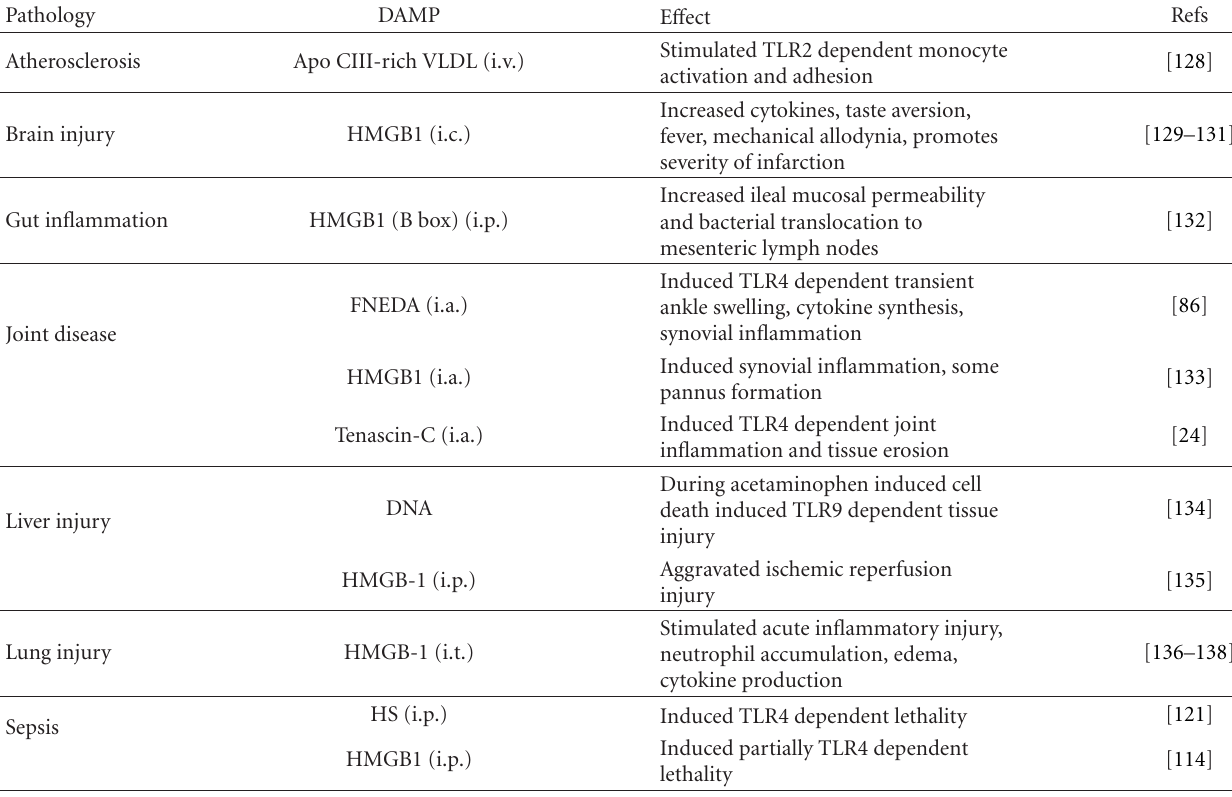
Table 1: DAMPs induce disease in vivo. Administration of DAMPs to rodents either intra-articularly (i.a.), intracerebroventricularly (i.c.), intraperitoneally (i.p.), intratracheally (i.t.), or intravenously (i.v.) can provoke pathological inflammation in vivo .